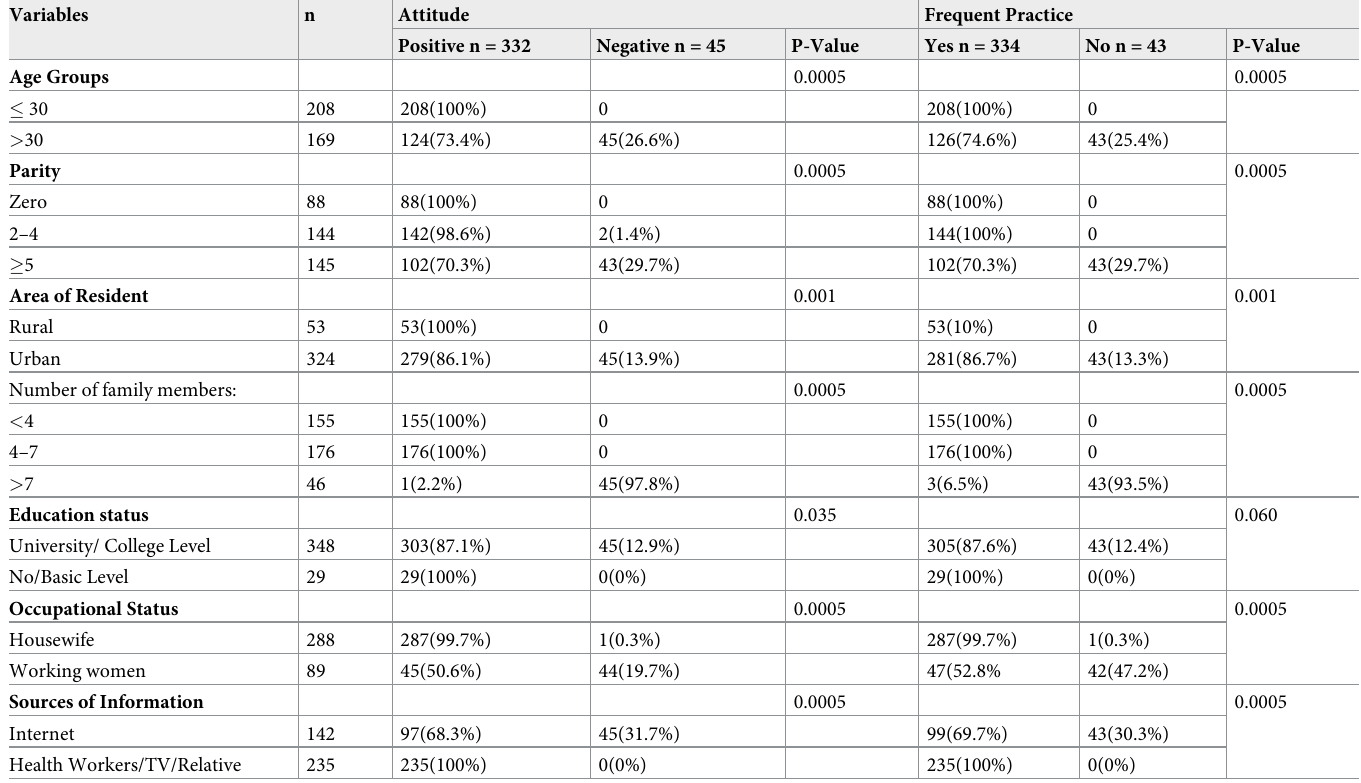
Table 5. In Univariate analysis, factors associated with attitude and practice of pregnant